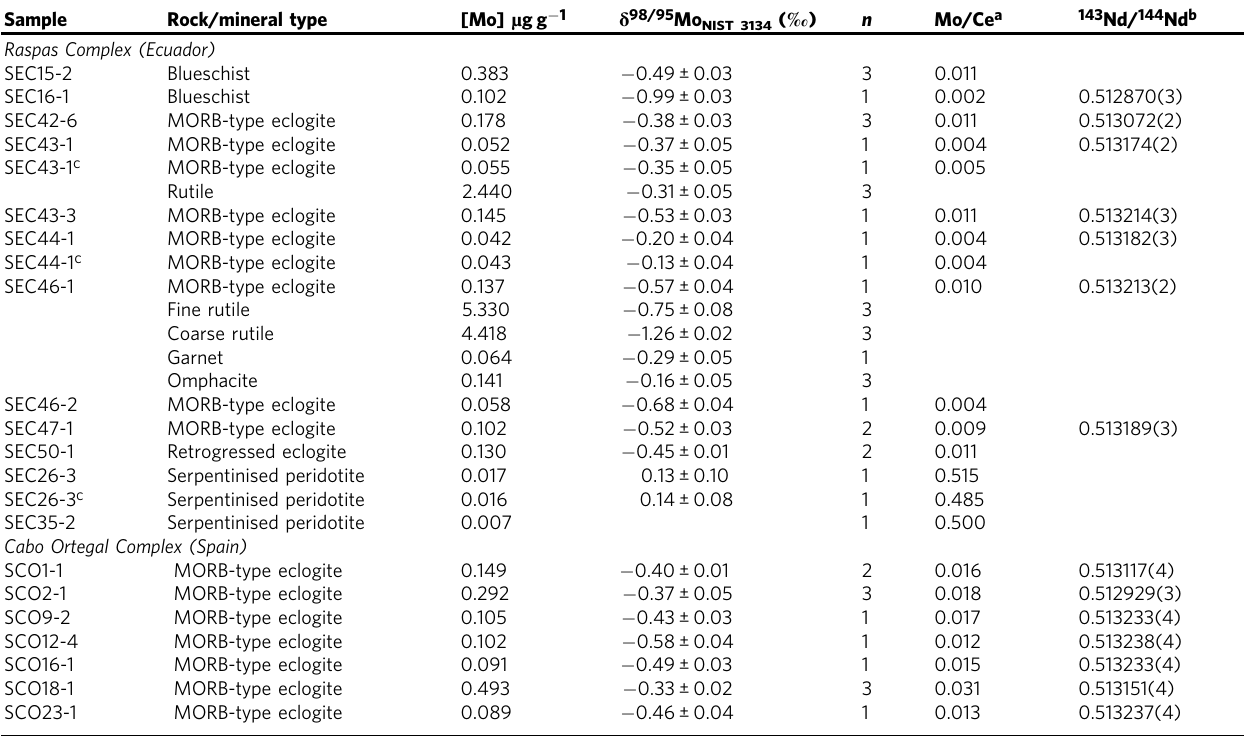
Table 1 δ 98/95 Mo NIST 3134 and Mo concentrations in high-pressure ma fi c and ultra-ma fi c samples from Raspas Complex and Cabo Ortegal Complex